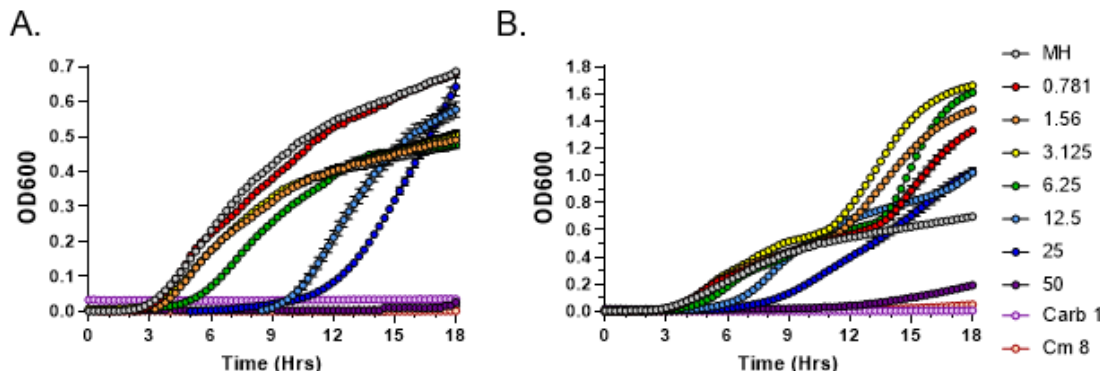
Figure 3. Broth microdilution method to determine the Minimal Inhibitory Concentration (MIC) of metabolites present in C. purpureus GG1 exudates. Exudates from two-week-old ( A ) and four-week-old ( B ) C. purpureus GG1 strains were tested in MIC assays against S. aureus ATCC25923. Growth curve of S. aureus cells was monitored in the presence of 0.781, 1.56, 3.125, 6.25, 12.5, 25, and 50 mg/mL of exudate solution. MH—negative control, no exudate added. Carbenicillin (Carb, 1 µg/mL) and chloramphenicol (Cm, 8 µg/mL) treatments were used as positive controls for S. aureus growth inhibition.